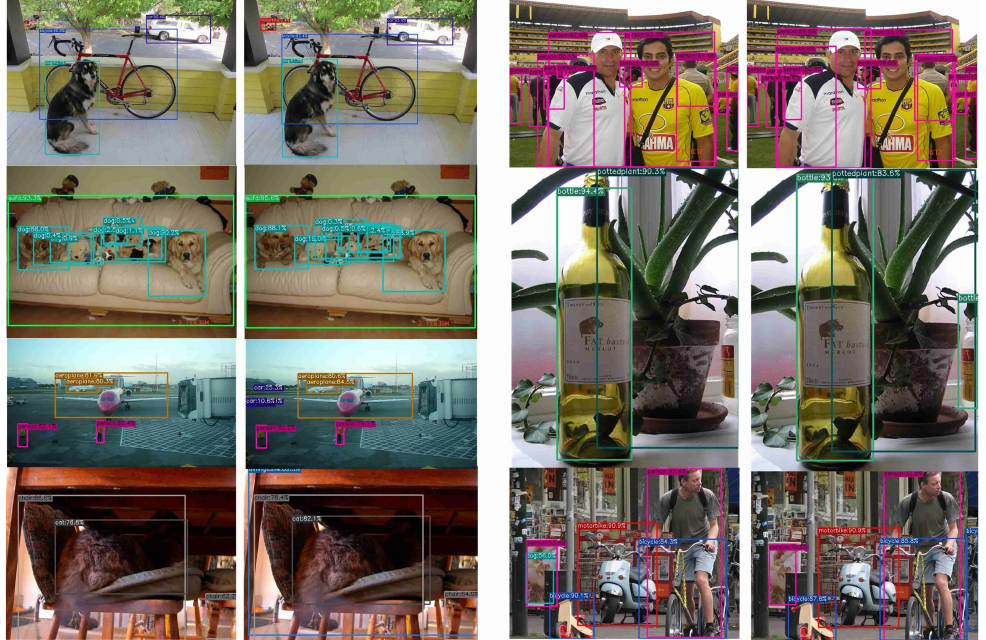
Figure 9. Visualization results of YOLOX-S and YOLOX-S 1 . Of the two sets of identical images, the left image is the detection output image of YOLOX-S and the right image is the detection output image of YOLOX-S 1